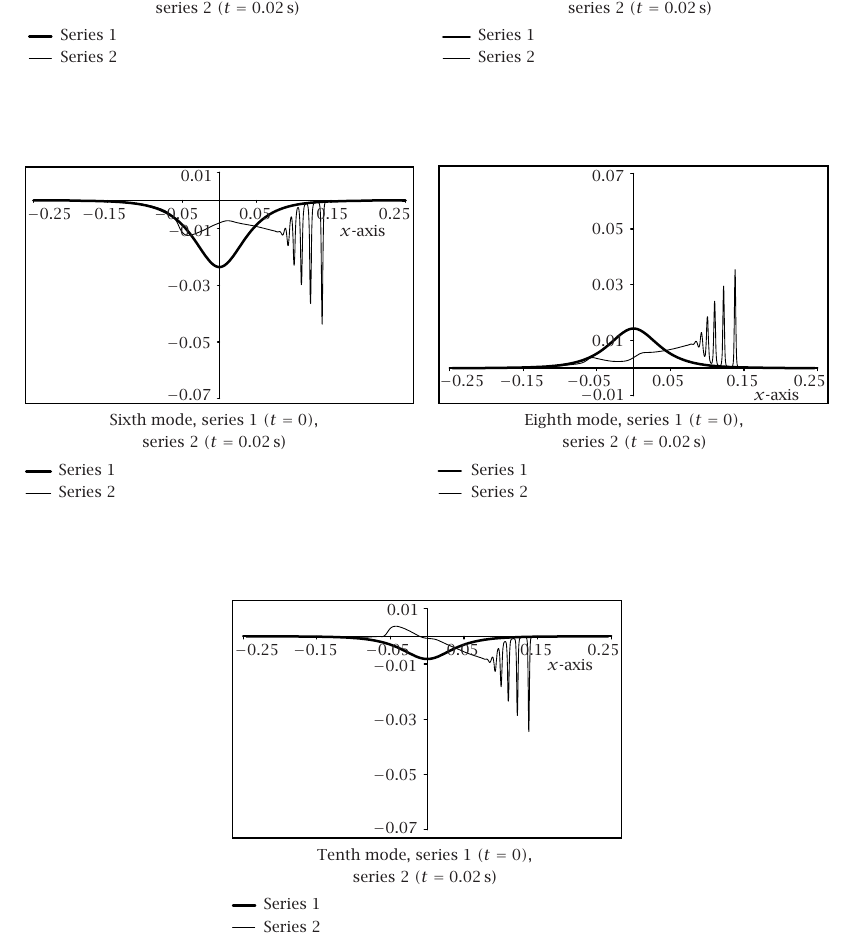
Figure 5.2 . One-dimensional (x) plots of the wave profile at t = 0 and t = 0 .